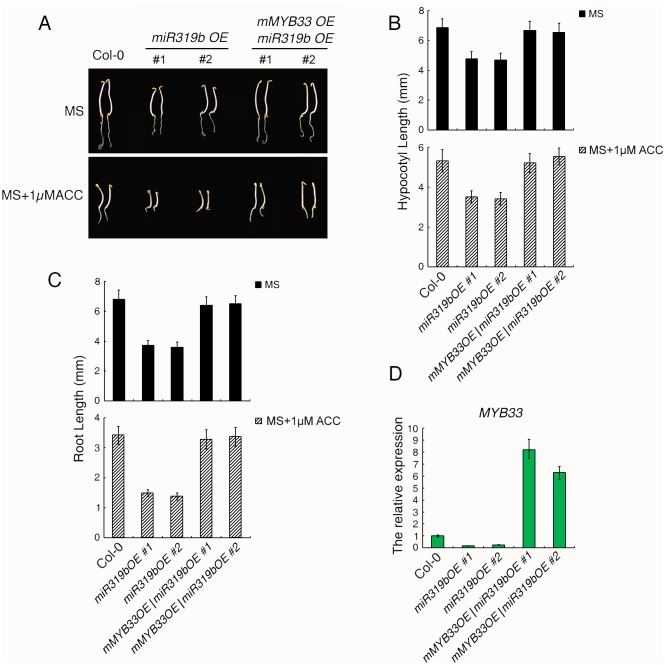
Mutated MYB33 with miR319b target sites is able to rescue the root phenotype caused by miR319bOE.(A) Triple response phenotype of miR319bOE plants, miR319bOE/mMYB33OE plants. (B-C) Measurement of hypocotyls (B) and roots (C) of miR319bOE and miR319bOE/mMYB33OE plants. (D) The relative gene expression of MYB33 in miR319bOE and miR319bOE/mMYB33OE plants. Total RNAs were extracted from the roots of 3-day-old etiolated seedlings from indicated genotypes and gene expression was analyzed by qualitative RT-PCR. Three replications have been done with similar result.